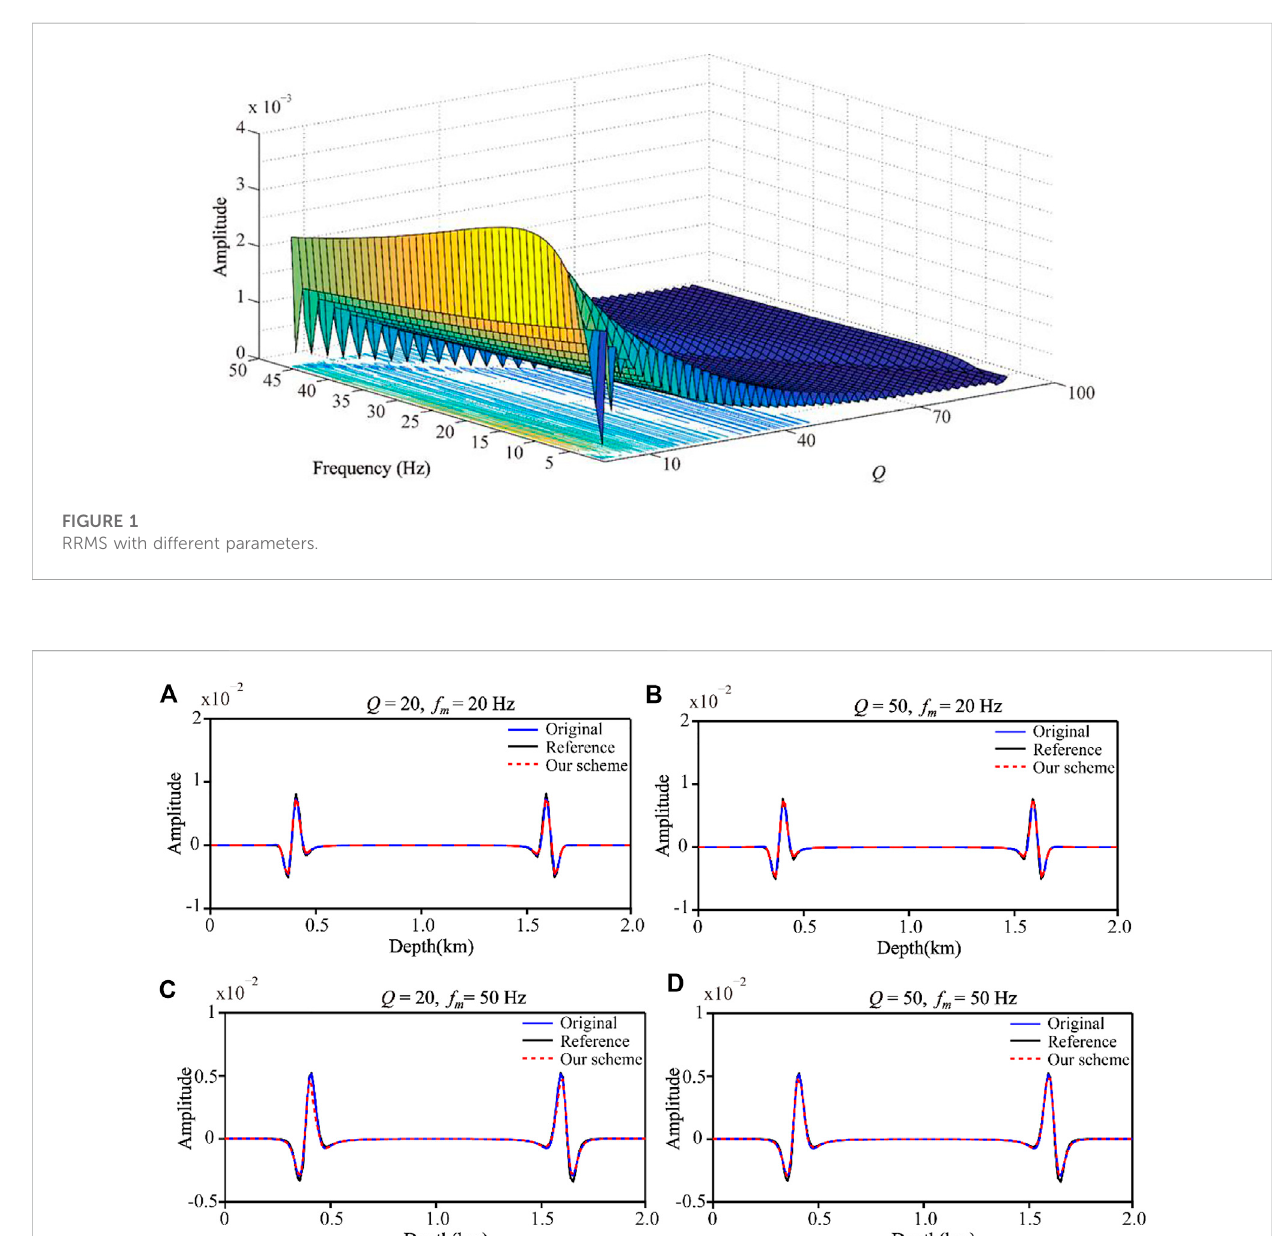
Frontiers in Earth